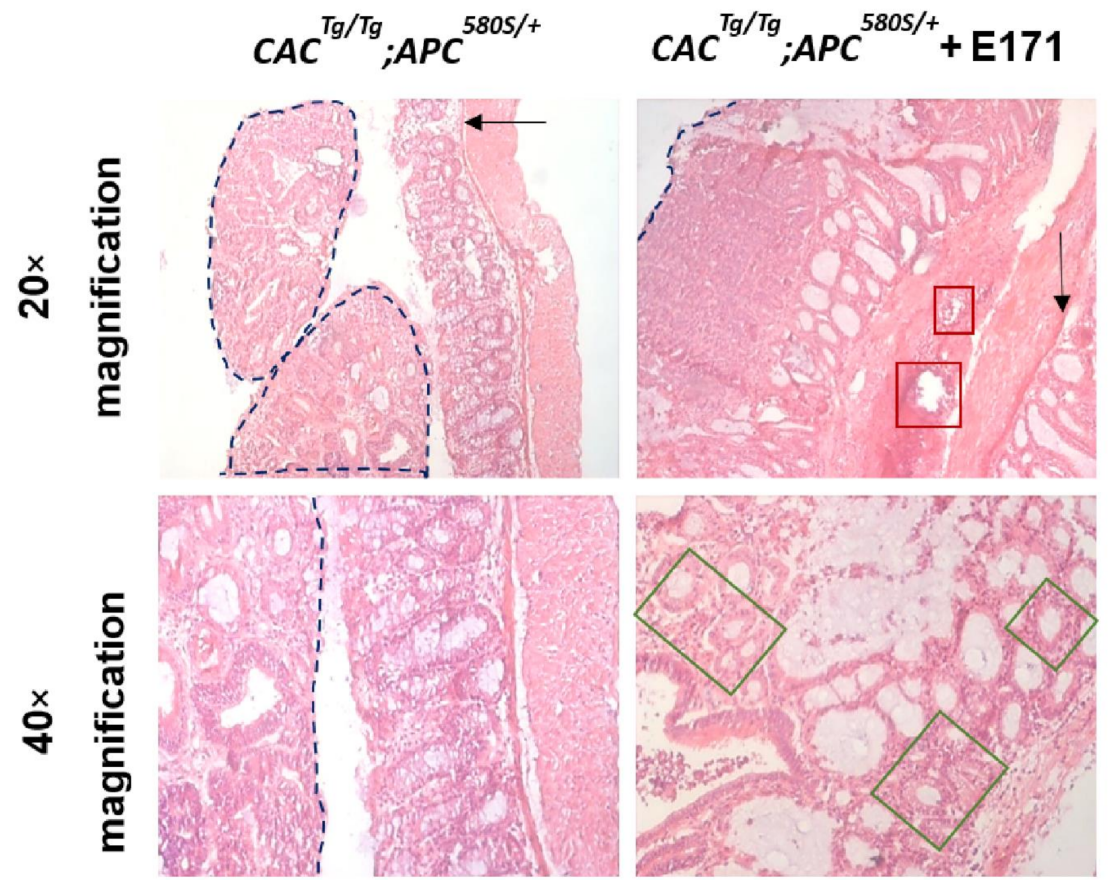
Figure 2. Histopathological analysis of tumors in control and E171-treated mice showed well- differentiated adenocarcinomas. The mice exposed to E171 additionally showed enhanced hyperpla- sia in the epithelial cells as well as in the lymph nodes at the base of the adenocarcinoma. Dotted blue lines—adenocarcinoma; black arrows—basal lamina; red squares—lymph nodes; green squares— enhanced number of epithelial cells